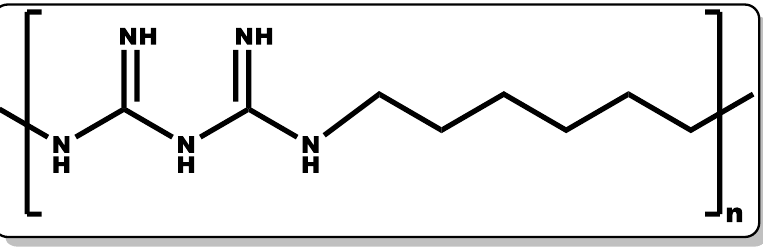
Figure 5. Structure of poly(hexamethylene biguanide).